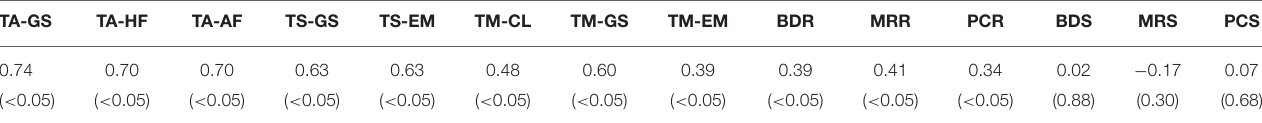
TABLE 5 | Age correlations for the TAG-Game scores, the raw WPPSI/WISC scores (i.e., Block Design raw score (BDR), Matrix Reasoning raw score (MRR), and Picture Concept raw score (PCR), and the standardized WPPSI/WISC scores (i.e., Block Design standardized score (BDS), Matrix Reasoning standardized score (MRS), and Picture Concept standardized score (PCS).